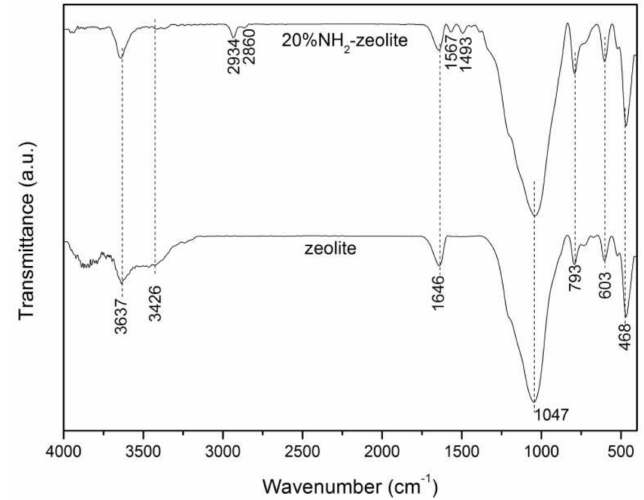
Figure 3. Fourier transform infrared analysis spectra of zeolite and 20% amino functionalized zeolite